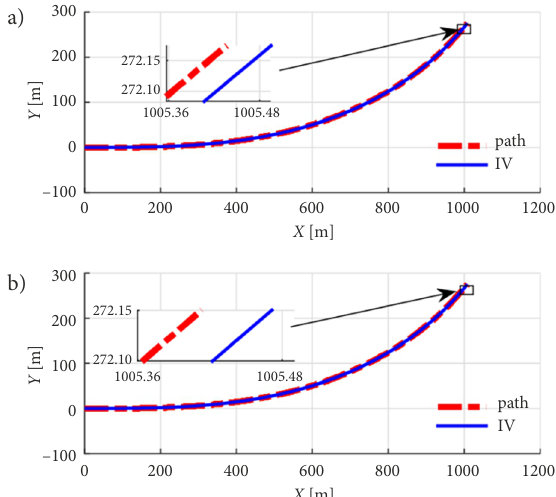
Figure 12. Path tracking performances of vehicles considering rear-end collision escape with different friction coefficients (source: created by the authors): a – high friction coefficient;